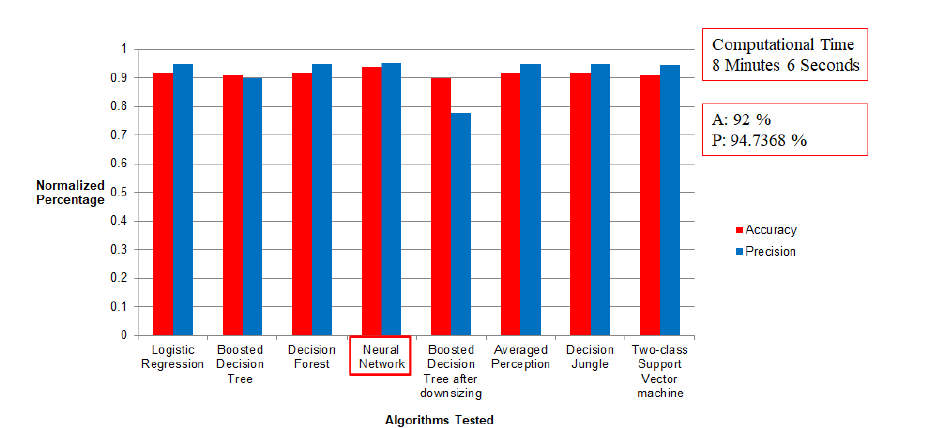
Figure 8. Binary classification model results for normal